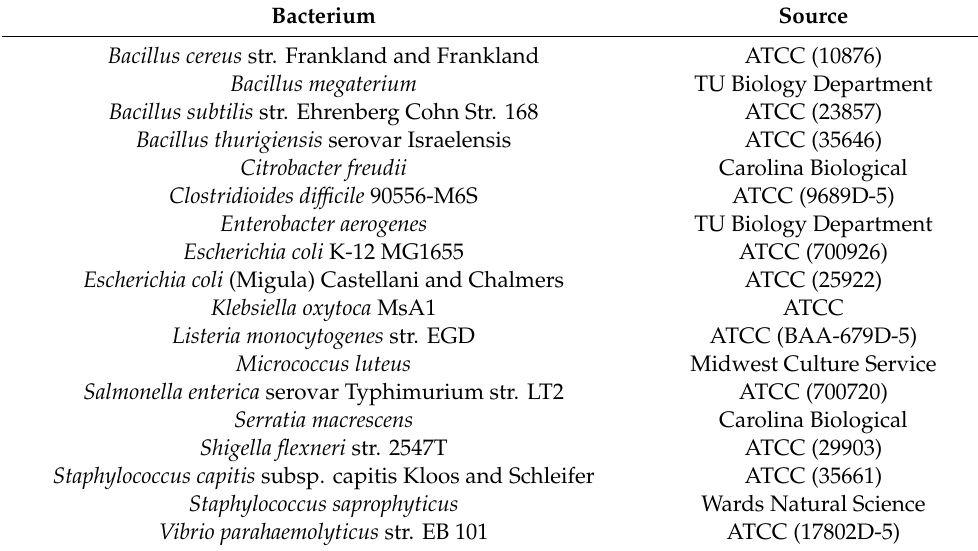
Table 1. Bacterial species and source used in assay development and specificity